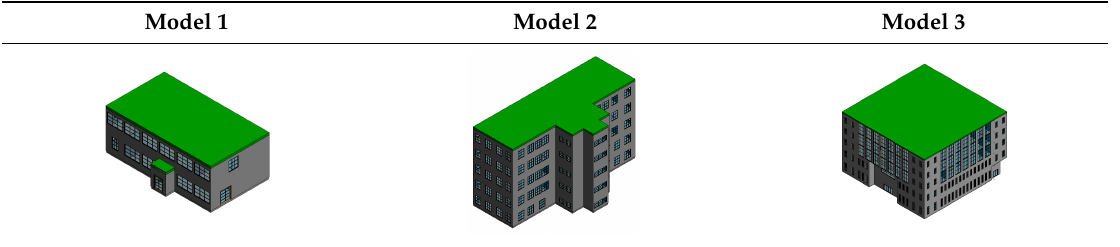
Table 2. Simulation models sample images (subject B modeling).